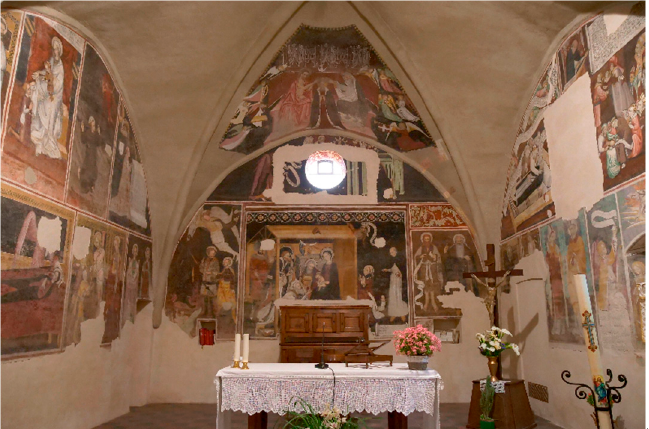
Figure 2. Set of frescoes in the apse of Santa Maria Assunta Parish Church (Macello, Piedmont). Aymo Duce and others, fifteenth century (photograph courtesy of Leonardo Guazzo).